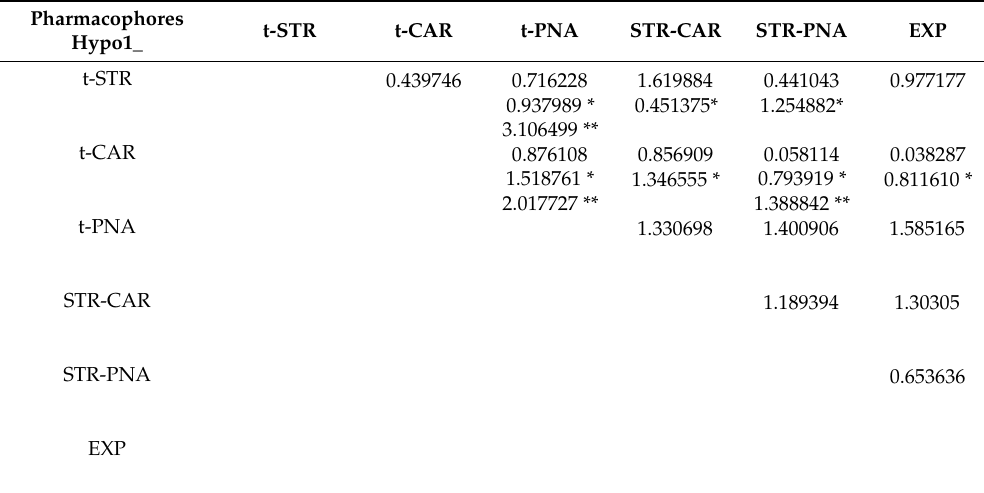
Table A2. RMSD values obtained by pharmacophore comparisons by